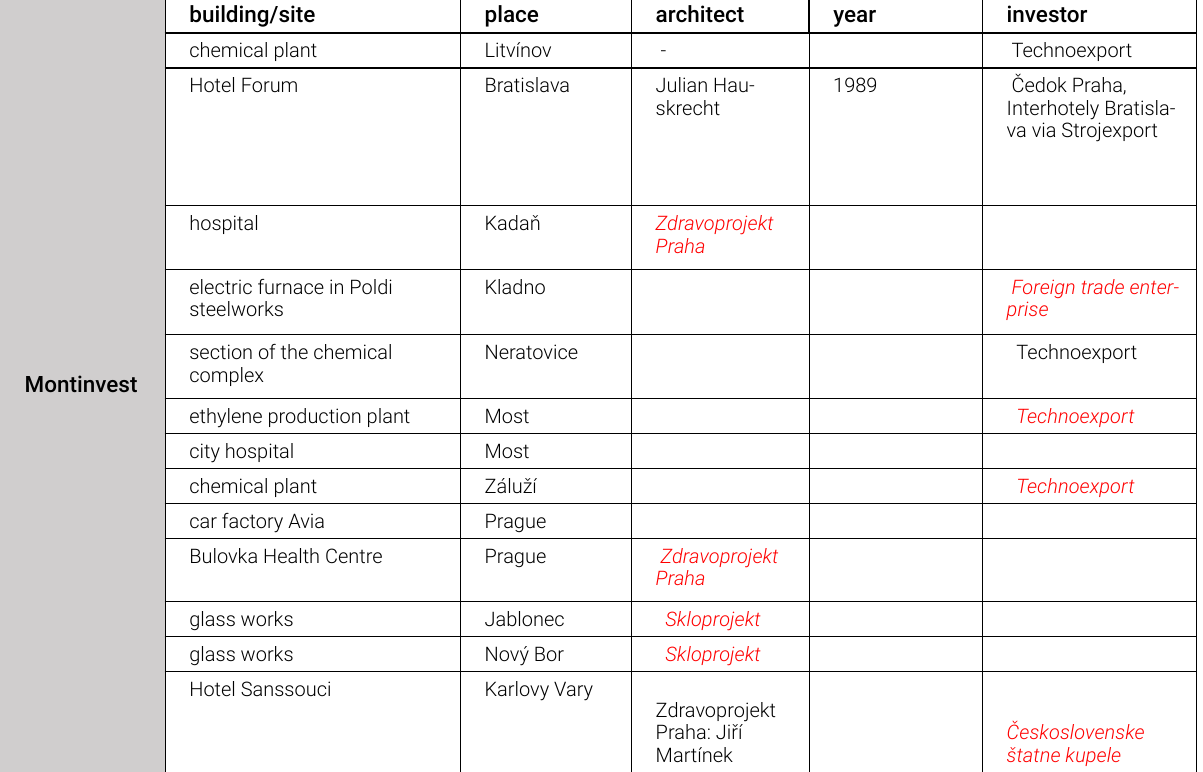
Table 4: Construction Sites of the KMG Trudbenik Construction Company